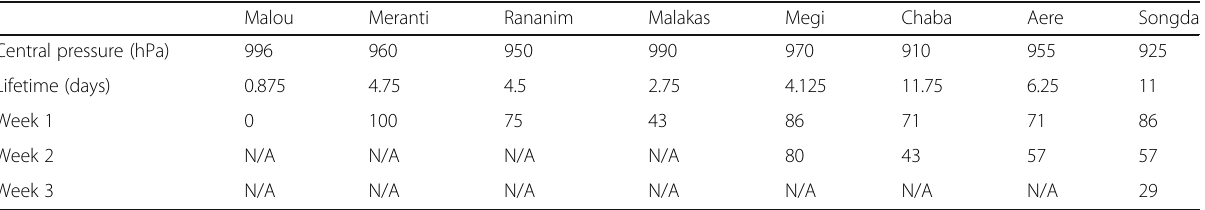
Table 1 Simulation performance for forecasting TC